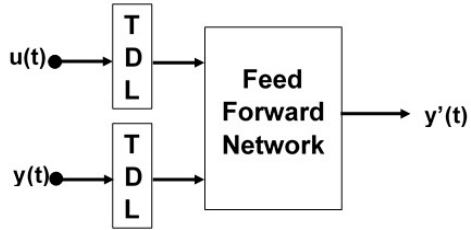
Figure 8. Series-parallel architecture for training a NARX.